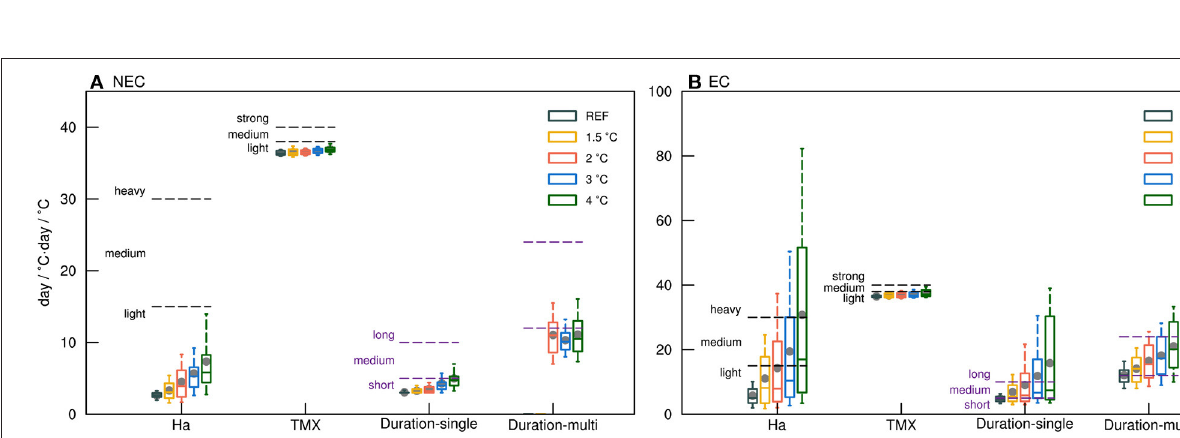
FIGURE 7 | Same as Figure 5 but averaged over Central and East China.